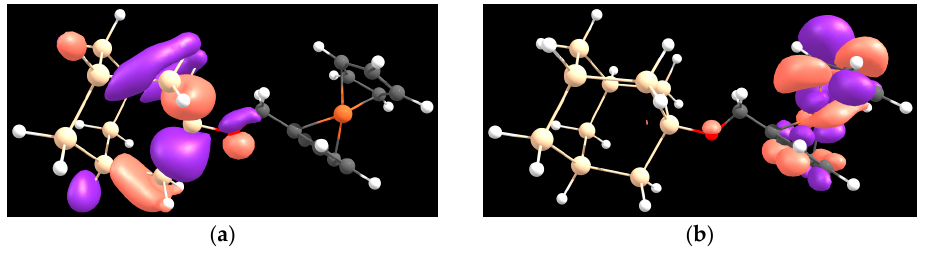
Figure 3. Plot of MOs involved in the V RP calculation for the Si M –Me–FC species. ( a ) Si M 1 + –Me–FC , molecular orbital representative of the positive charge localized on the donor state; ( b ) Si M –Me–FC 1 + , molecular orbital representative of the positive charge localized on the acceptor state. Table 2. Theoretical values used in the calculation of k ET , Equation (1). Redox